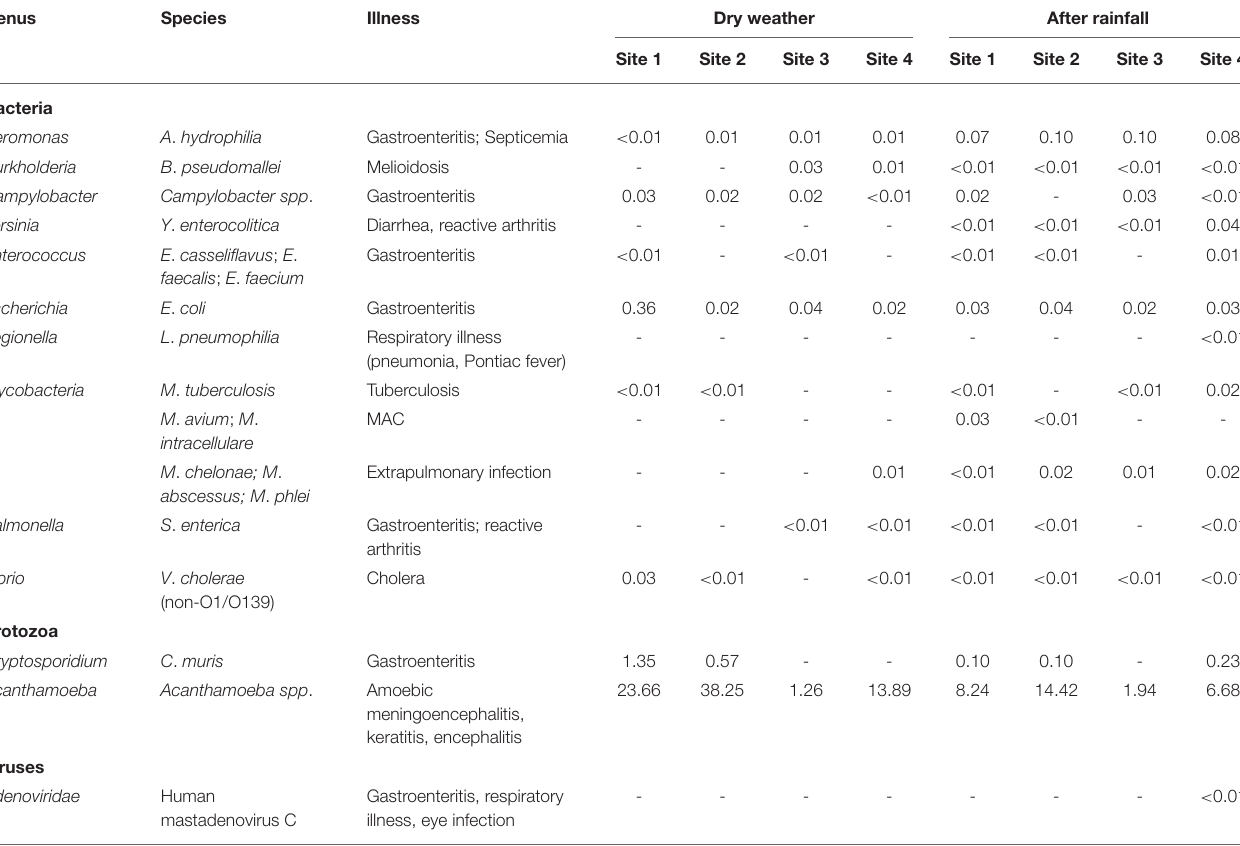
TABLE 2 | Relative sequencing read abundance of wastewater enteric microorganisms detected in urban watershed microbiomes.